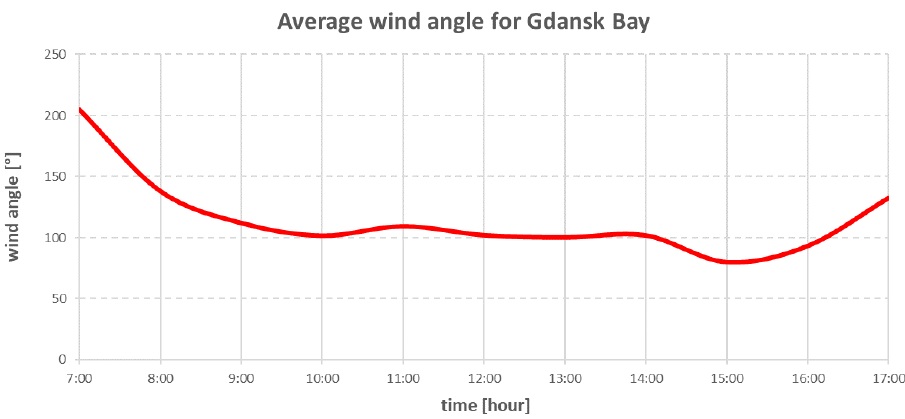
Figure 8. Averaged wind angle changes in Gdansk Bay on 19 May 2022.